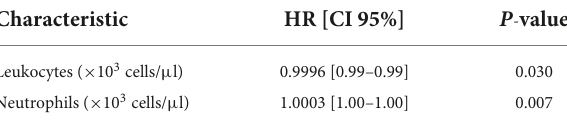
TABLE 3 Analysis of risk factors associated with mortality in severe COVID-19 patients by adjusted model.